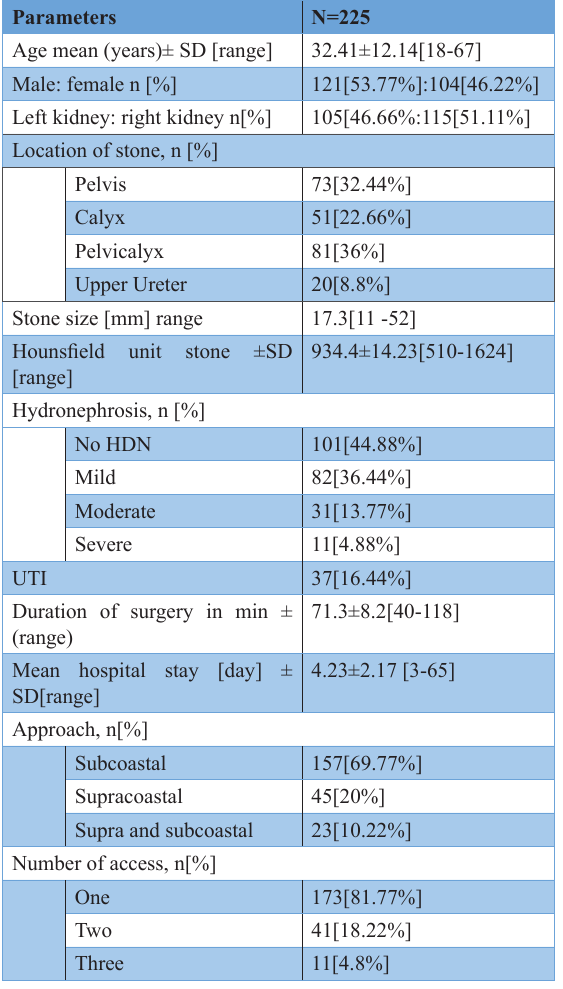
Table 1. Baseline characteristics and operative